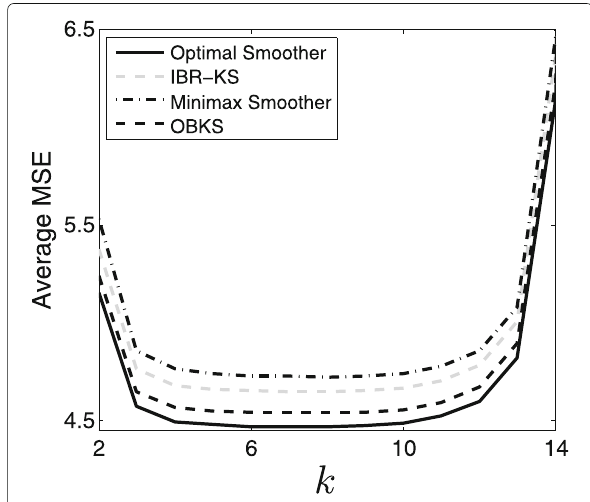
Fig. 5 Performance analysis over the observation window for the target tracking example with unknown r and q . Average MSE of different smoothers for each k over the observation window when both q and r are